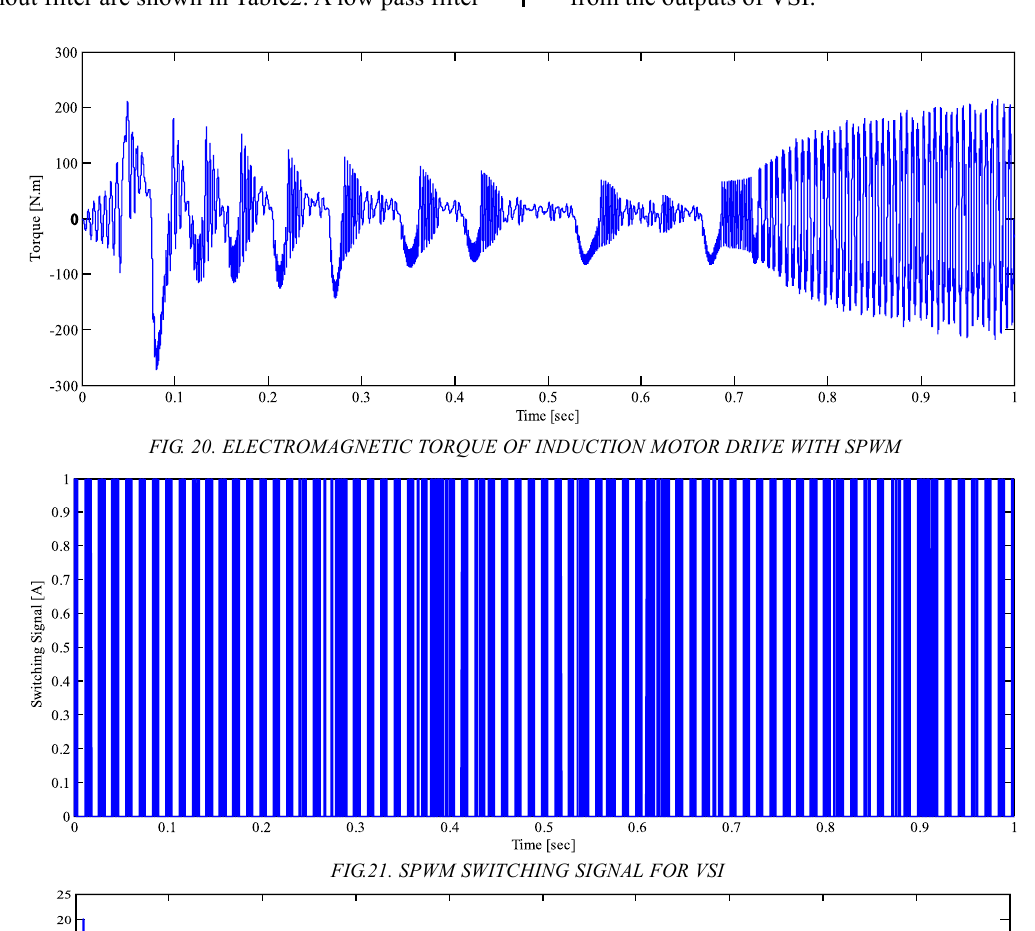
FIG.21. SPWM SWITCHING SIGNAL FOR VSI